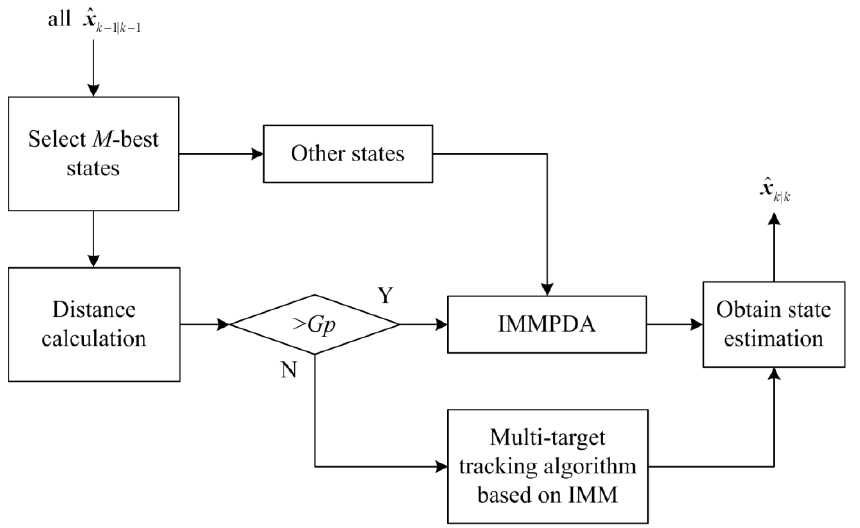
Figure 4. Tracking techniques block